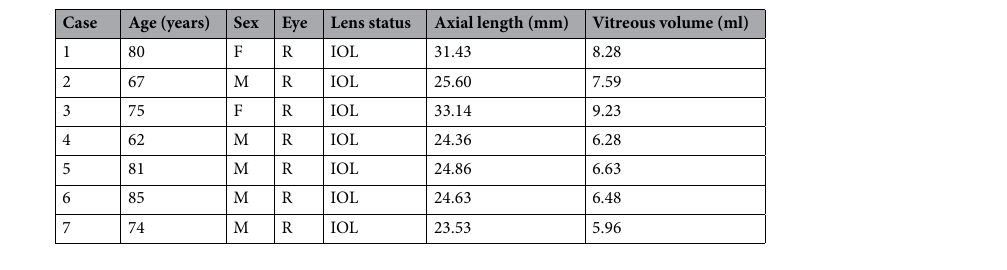
Table 1. Patient